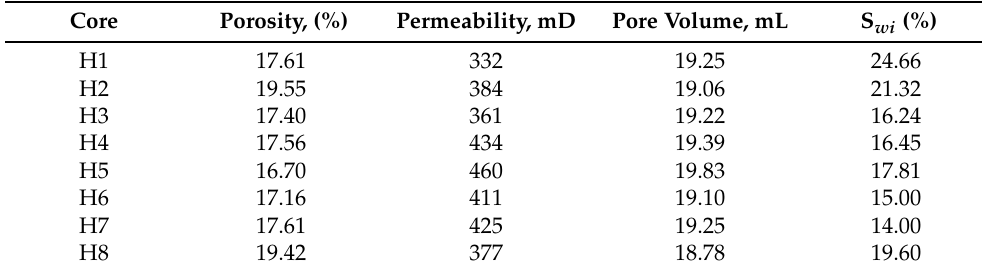
Table 4. Properties of the rock core